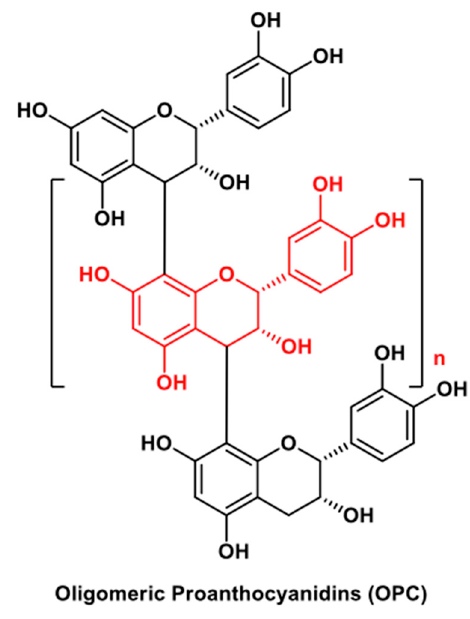
Figure 8. General structure of the oligomeric proanthocyanidins (OPC; n = 0–7).